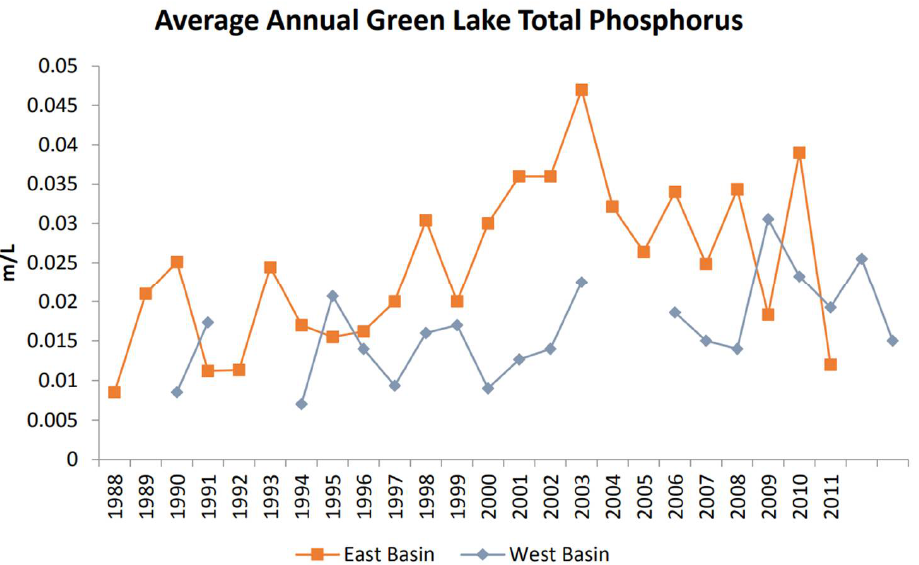
Figure 3. Average annual epilimnetic total phosphorous at Green Lake [4].